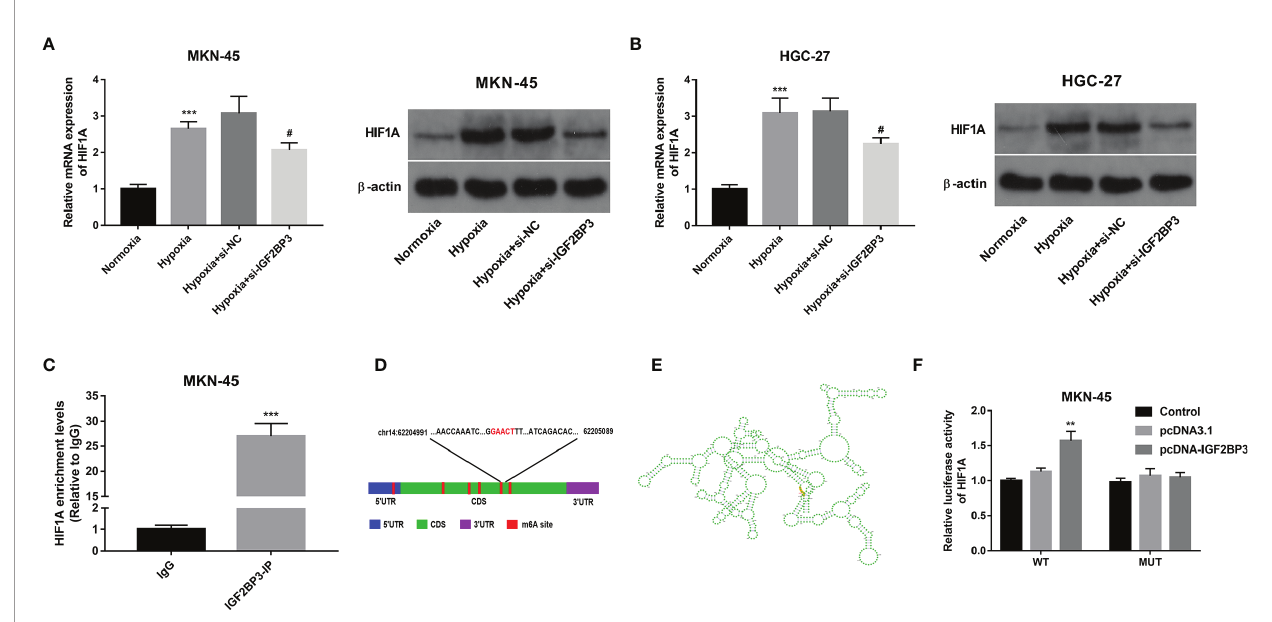
FIGURE 4 | IGF2BP3 positively regulated HIF1A expression in an m6A-dependent manner. (A, B) MKN-45 and HGC-27 cells were transfected with si-NC or si-IGF2BP3#1 for 48 h and then maintained in hypoxic conditions for another 24 h Cells in the normoxia group were maintained in normoxic conditions for 72 h Cells in the hypoxia group were cultured in normoxia for 48 h and then exposed to hypoxia for an additional 24 h Next, HIF1A mRNA and protein levels were measured through RT-qPCR and western blot assays, respectively. (C) RIP assay was performed using IgG or IGF2BP3 antibody in MKN-45 cells. HIF1A level in IgG or IGF2BP3 immunoprecipitation complex was measured through RT-qPCR assay. (D, E) Putative m6A modi fi cation and IGF2BP3 binding site on HIF1A mRNA. (F) Luciferase activities were measured at 48 h post-transfection. ** p < 0.01, *** p < 0.001, # p <